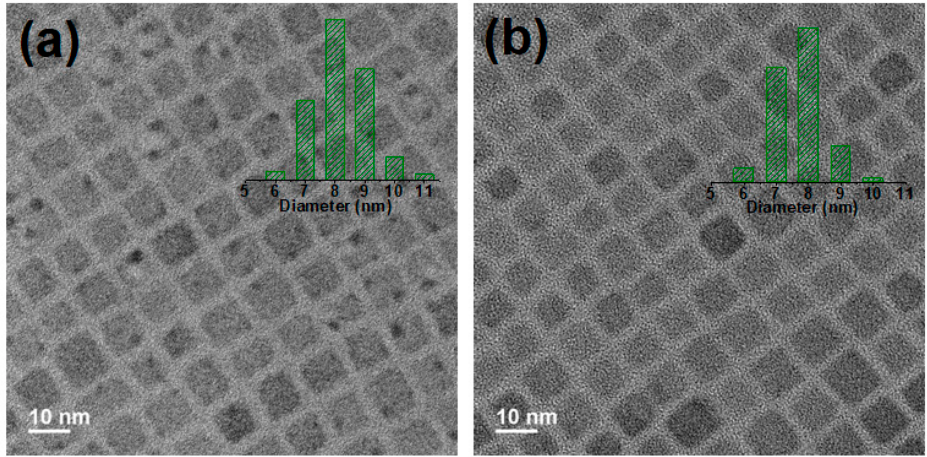
Figure 1. High-resolution TEM images of ( a ) CsPbBr 3 and ( b ) CsPbBr 3 :Zn NCs. Insets show the histograms of edge lengths of corresponding NCs.